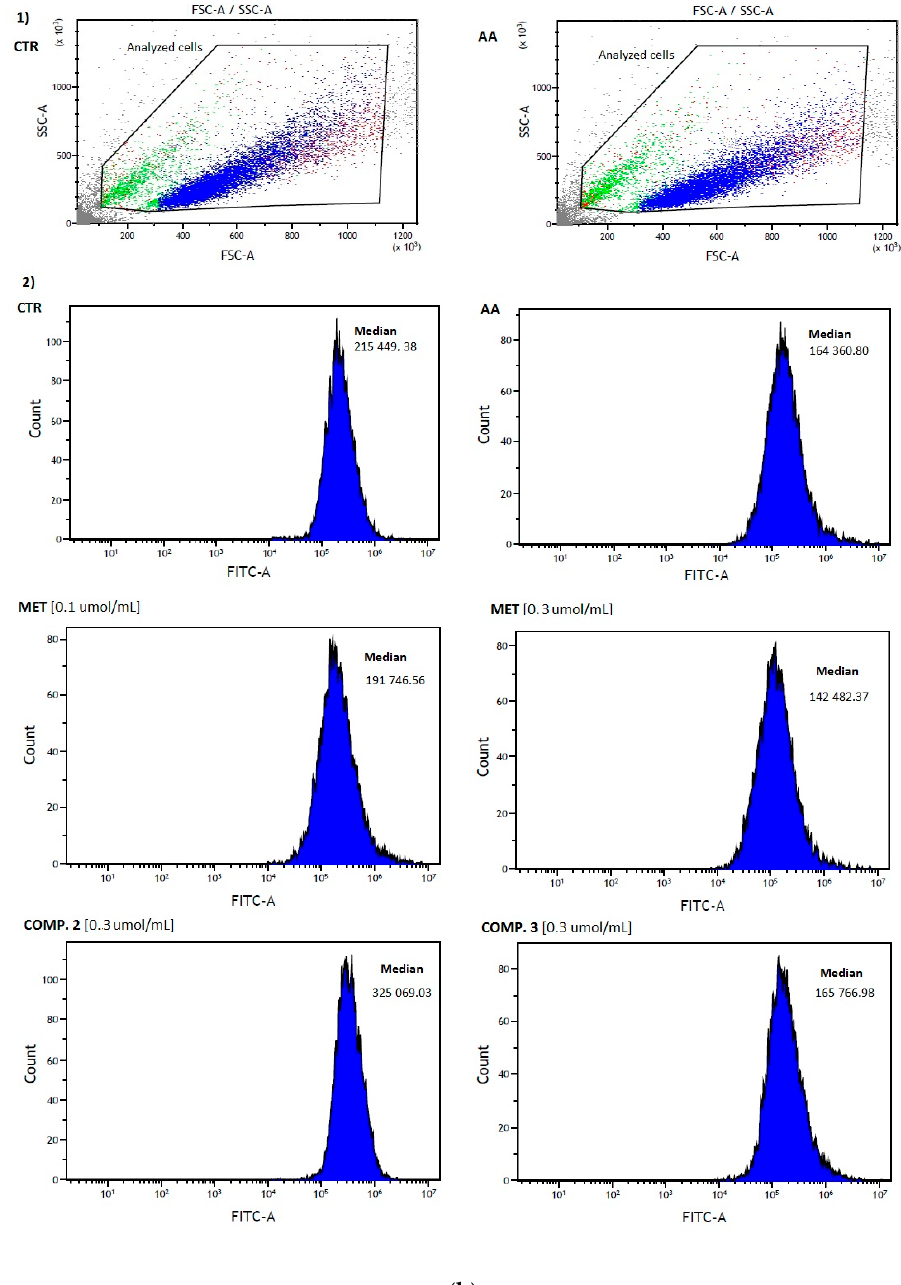
Figure 7. Effects of selected biguanides on the production of intracellular reactive oxygen species. The experiments were performed using 2 ′ ,7 ′ -dichlorodihydrofluorescein diacetate (H 2 DCFDA), a fluorescent indicator for ROS in cells. The fluorescence of stained HUVECs was measured by flow cytometry. ( a ) Summary of the effects of metformin, compound 2 , 3 , 4 , 6 and 10 on the H 2 DCFDA fluorescence in viable HUVEC cells. The results are presented as median ± range, n = 3). The asterisk denotes a statistically significant difference in comparison to control, * p < 0.05. Ascorbic acid ( AA ) was used as a reference compound; ( b ) Flow cytometry analysis of the intracellular fluorescence in HUVECs. ( a ) Representative histograms of unstimulated HUVECs (control), and HUVECs treated with ascorbic acid (0.1 µmol/mL)—forward and side scatter plot of HUVECs; the analyzed cells are gathered in black frame. ( b ) Representative cytograms of analyzed cells treated with metformin (0.1 and 0.5 µ mol / mL), and compounds 2 and 3 (0.5 µ mol / mL). Median fluorescence intensity of analyzed cells is indicated in every